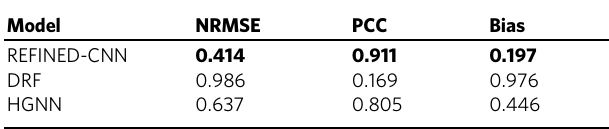
Table 3 Comparison of REFINED-CNN with DRF and HGNN for GDSC